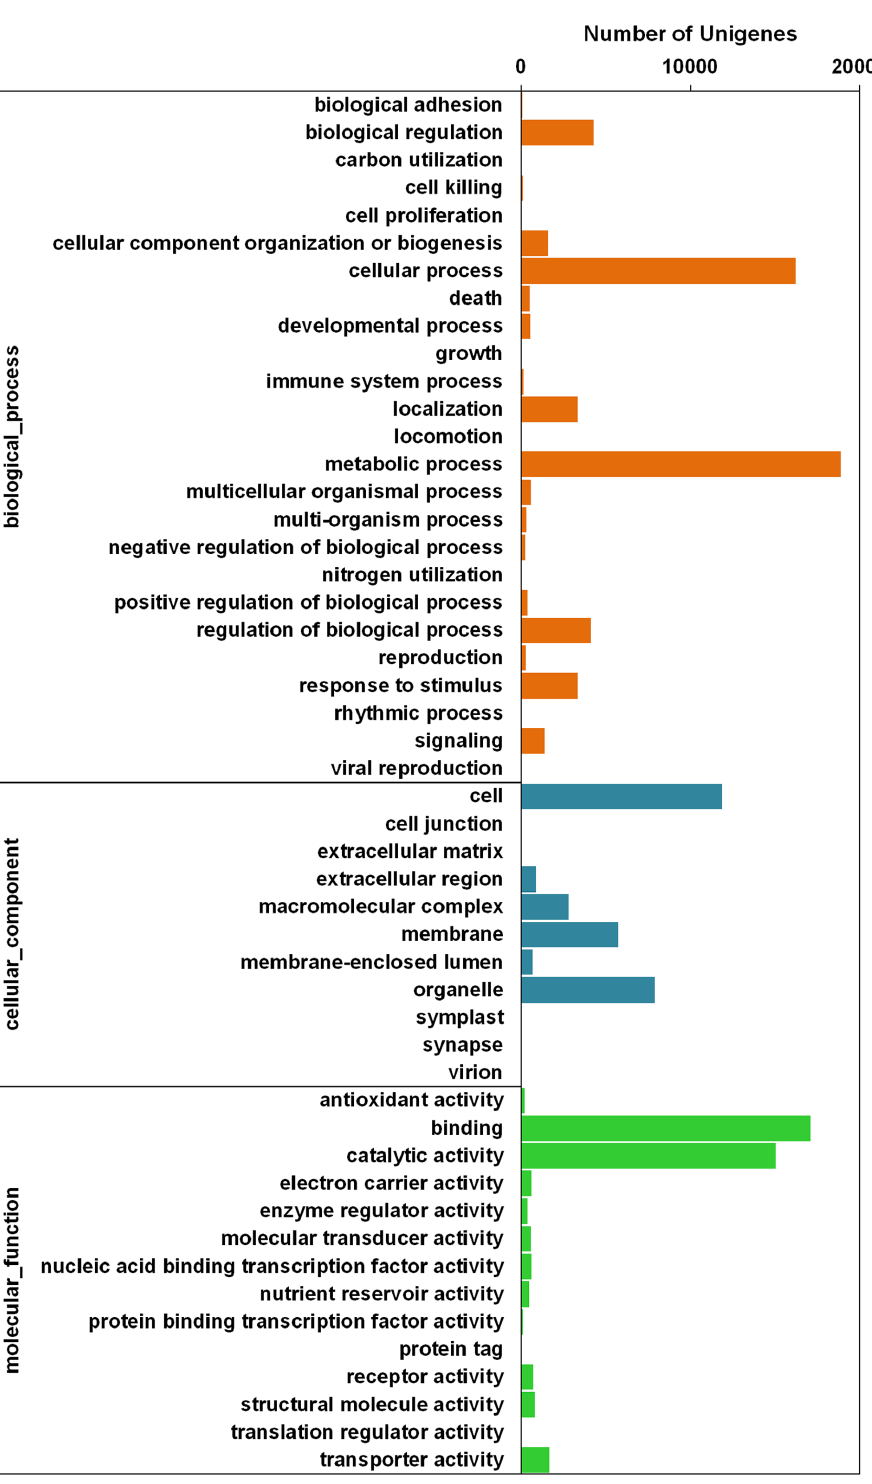
FAD8, EC:1.14.19.-), which further desaturates linoleic acid (18:2) to form a -linolenic acid (18:3), etc . In total, six, five, two, one, five and one unigenes that encode AAD, FAD2, FAD3, FAD6, FAD7 and FAD8 were found (Table 3). Oleic (18:1) and